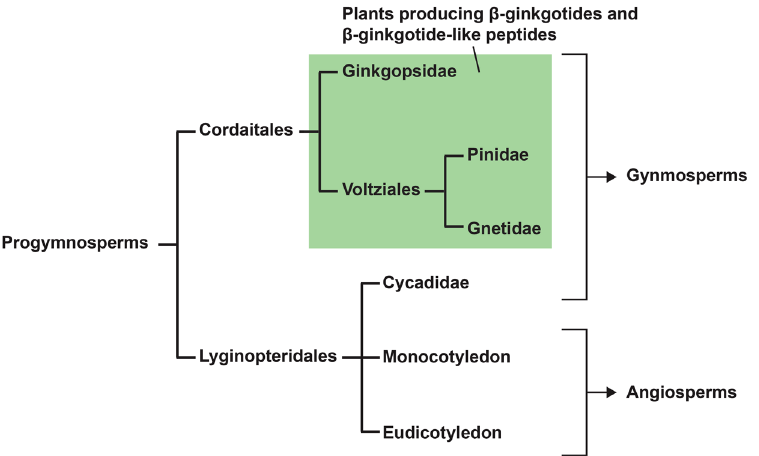
Figure 7. Occurrence of β -ginkgotide-like peptides in planta . Modern seed plants were evolved from a common ancestor progymnosperms and were separated into two major clades, Cordaitales and Lyginopteridales. Ginkgotide bL1 and bL1-like peptides were distributed only in Ginkgopsidae, Gnetidae and Pinidae (highlighted in green) but absent in Cycadidae and